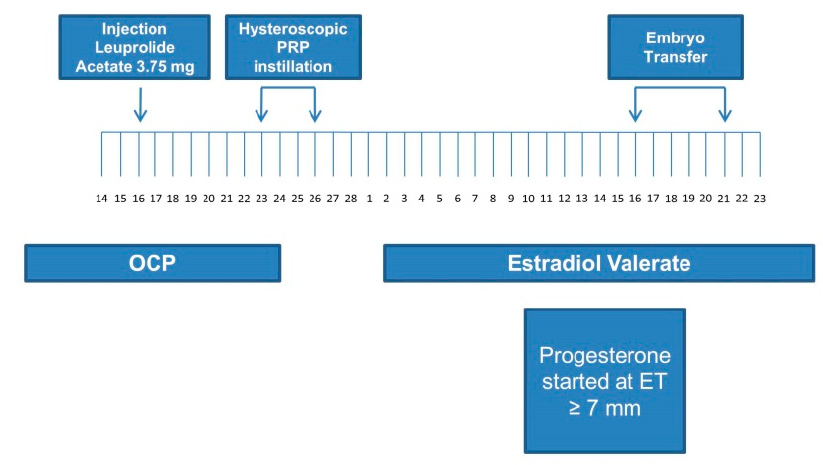
Figure 1. Preparation and procedure of the platelet-rich plasma instillation. OCP: oral contraceptive pills; PRP: platelet-rich plasma; ET: endometrium thickness.